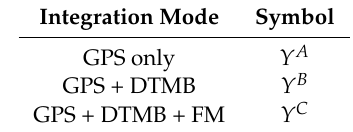
Table 1. Symbols for integration modes.